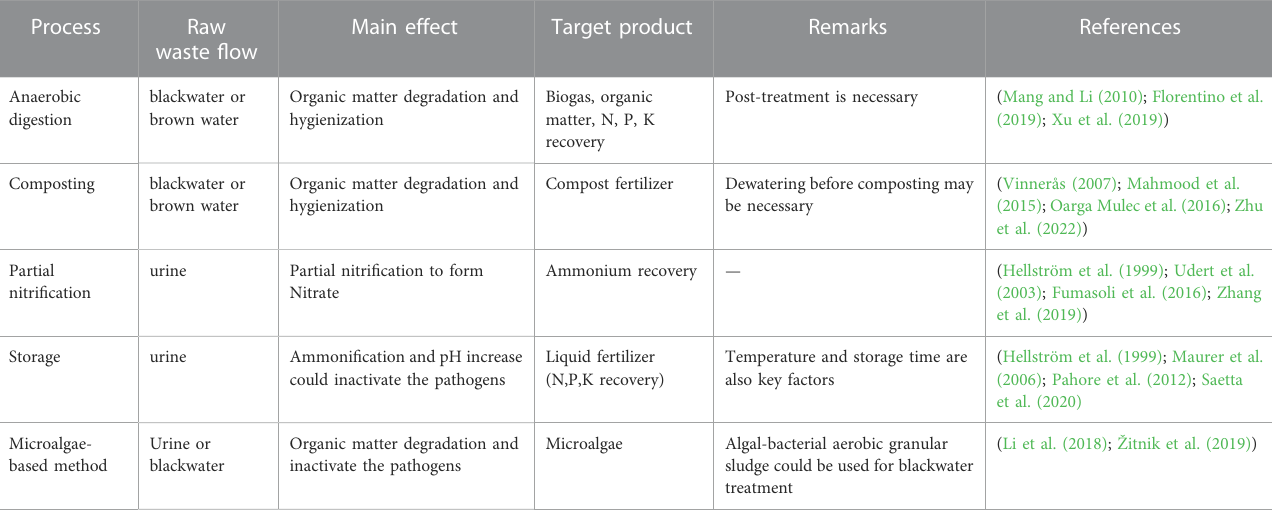
TABLE 5 Biological processes for blackwater